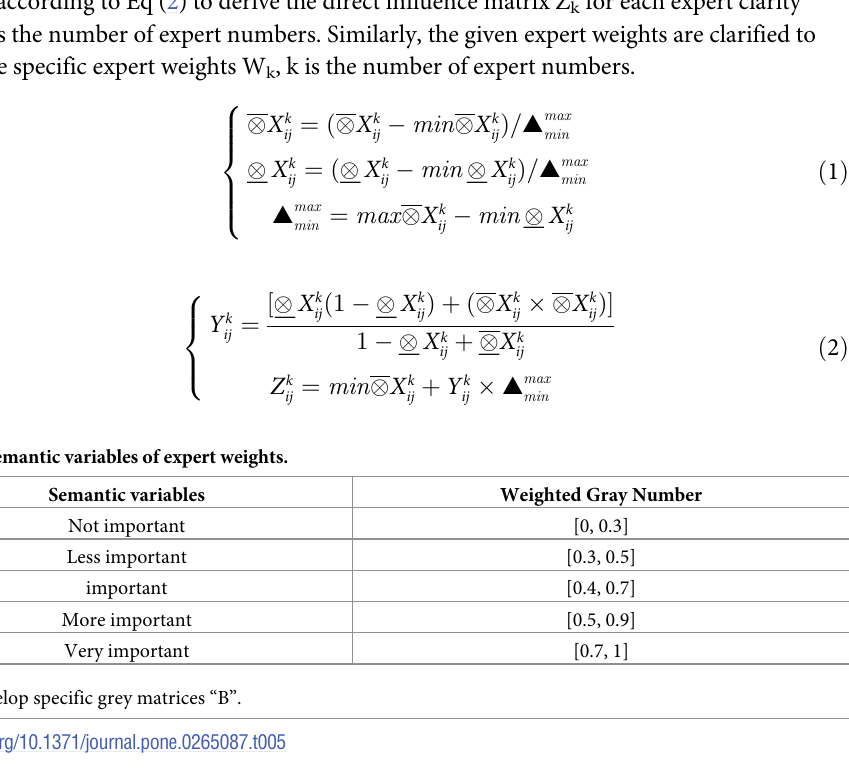
Table 6. Semantic variables of the expert evaluation gray numbers.